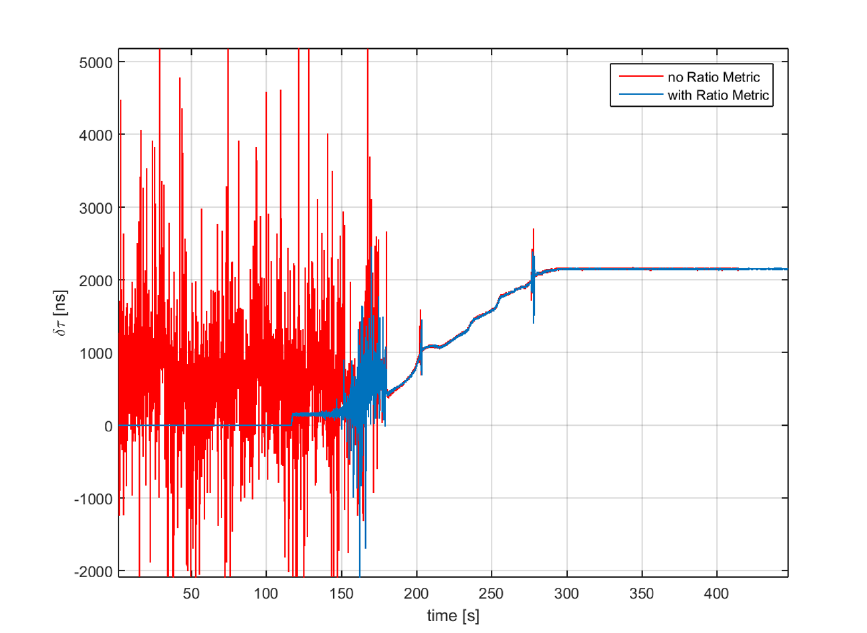
Figure 8. Delay estimation for a spoofing attack scenario. In red is depicted the decision when no RM is used and in blue when using RMs inside the monitoring block.